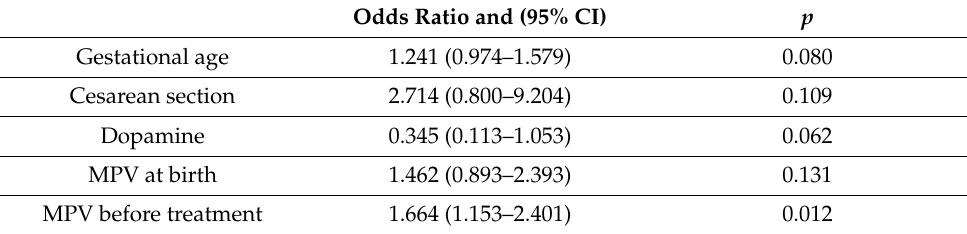
Table 3. Regression analysis correlating the effect of selected variables with the effectiveness of paracetamol on hsPDA